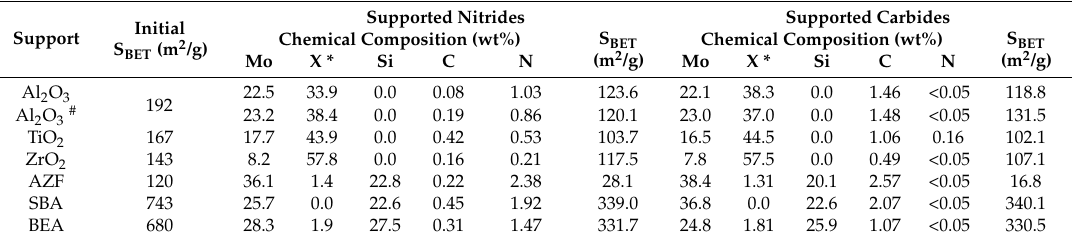
Table 3. Chemical composition and specific surface areas of the supported